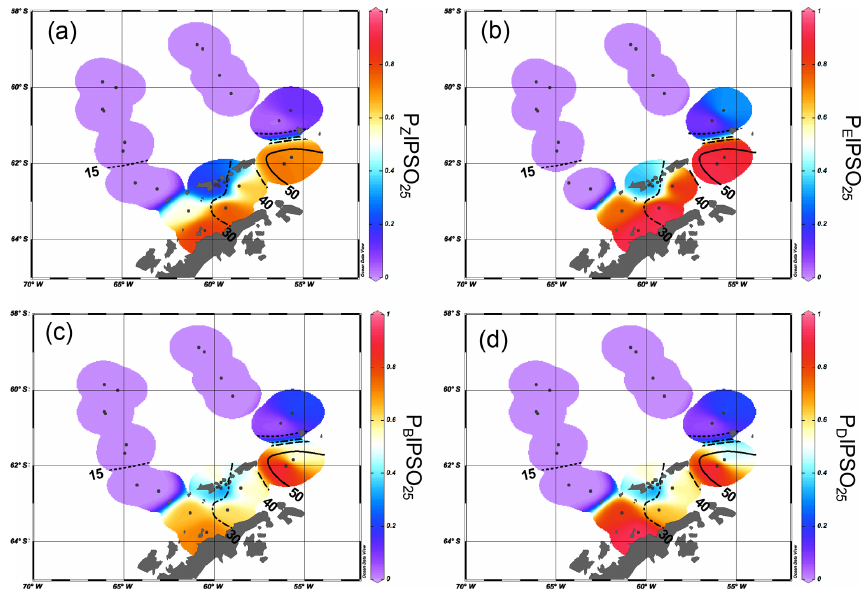
Figure 6. Distribution of (a) P Z IPSO 25 , (b) P E IPSO 25 , (c) P B IPSO 25 and (d) P D IPSO 25 values in the study area. The extent of 15%, 30%, 40% and 50% satellite sea ice concentrations during winter is added as contour lines (see also Fig.